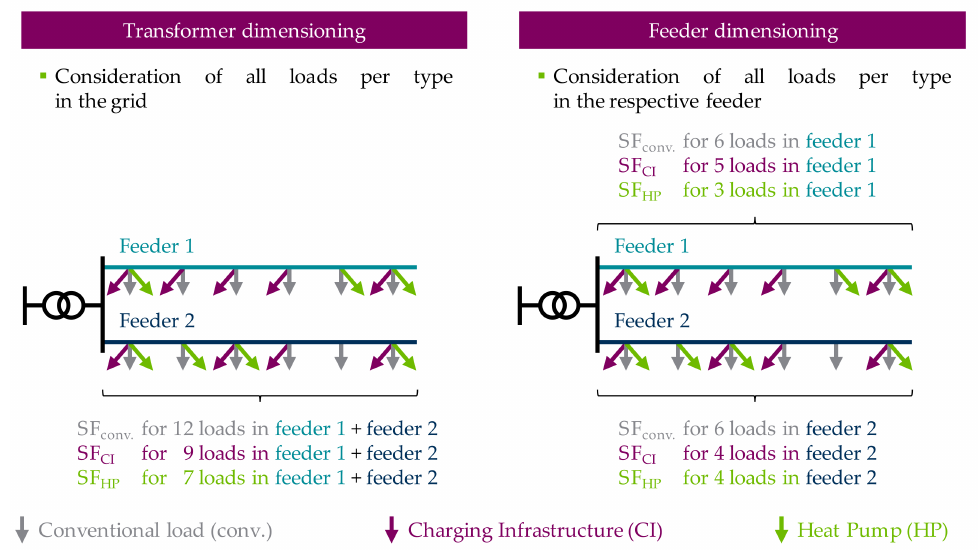
Figure 4. Planning perspectives taking into account the respective simultaneity factor